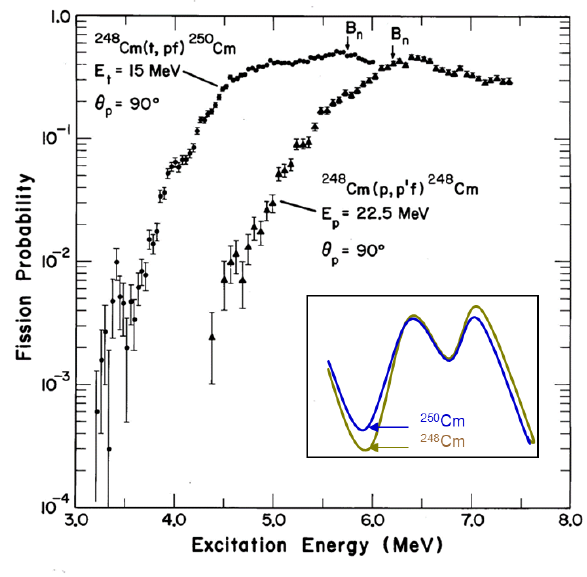
Figure 7. The fission probability functions for 248 Cm and 250 Cm populated in the 248 Cm(p,p’f) and 248 Cm(t,pf) reactions, re- spectively, show a large 1MeV shift caused by the closed ⇠ N = 126 shell lowering the ground state energy of 248 Cm relative to 250 Cm while the fission barriers are not appreciably a ↵ ected [19]. Figure 8. Fission barrier parameters (see text for definition) are shown for fifteen even-even actinide nuclei